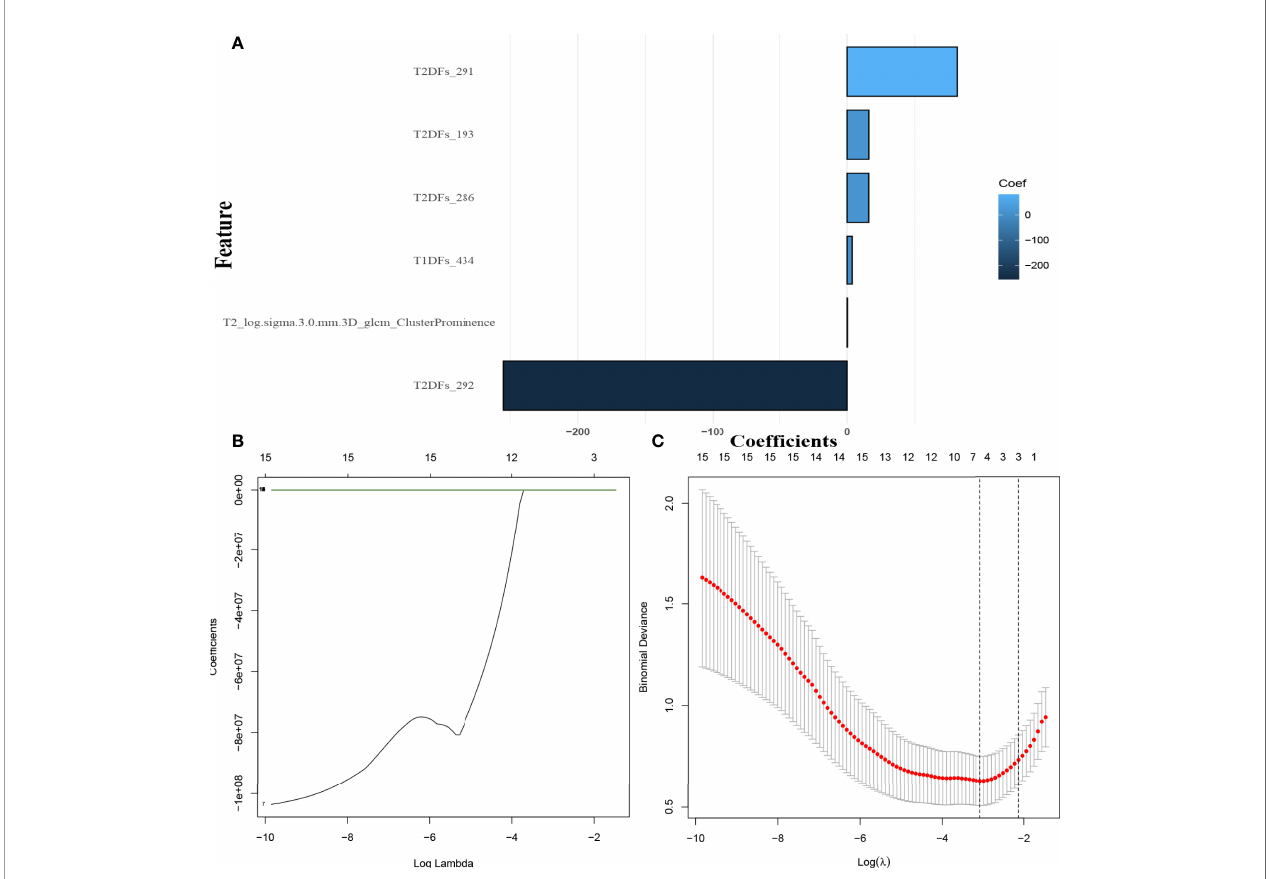
FIGURE 2 | Selection of MRI hand-crafted radiomics and deep learning features. (A) The six radiomics features with non-zero coef fi cients in the HD-Combined model. (B) The coef fi cients plot (as ln l ). (C) Selection of the tuning parameter ( l ). l =0.057(ln l =-2.86) was